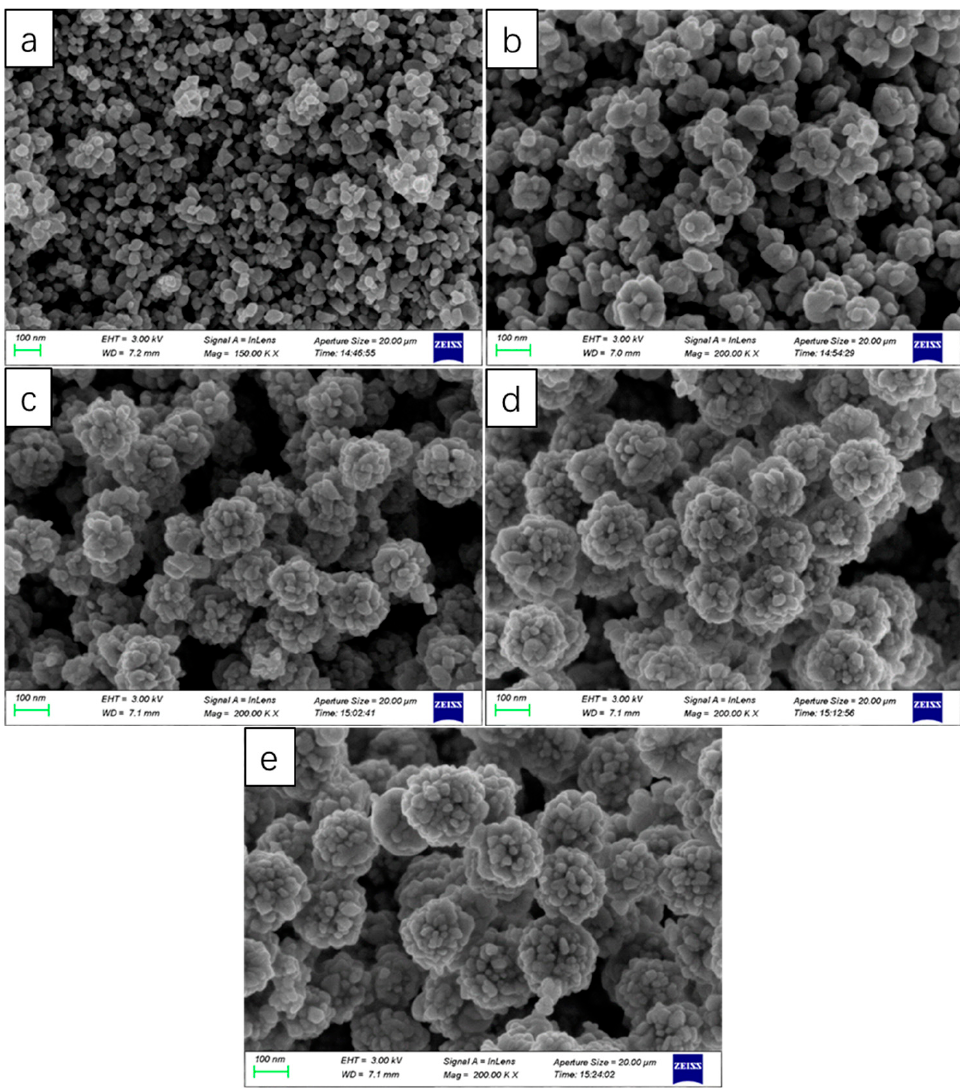
Figure 2. SEM image of Fe 3 O 4 . The amounts were: ( a ) 0.4 g NaOH; ( b ) 0.2 g NaOH; ( c ) 0.1 g NaOH; ( d ) 0.05 g NaOH; and ( e ) without using NaOH.